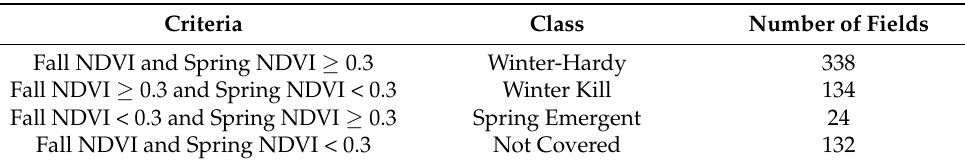
Table 3. NDVI criteria to characterize winter cover crops growth. Criteria Class Number of Fields Fall NDVI and Spring NDVI ≥ 0.3 Winter-Hardy 338 Spring